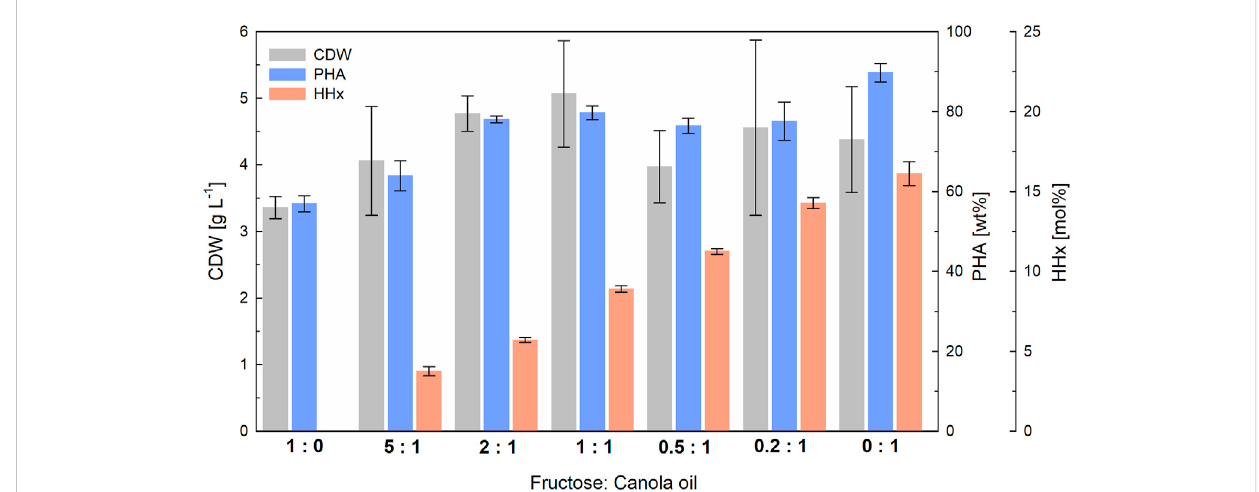
FIGURE 2 Impactofdifferentfructoseto canola oilmixture ratiosonthecompositionofP(HB- co -HHx) in3-mL deep-well-plate cultivations with R. eutropha Re2058/pCB113usingureaasnitrogensource.Celldryweight(CDW;gL − 1 ),PHAcontentofCDW(wt%)andHHxcontentofPHA(mol%)achievedafter72 h with different mixtures with a fi nal carbon content of 5 g L − 1 and a C/N ratio of 22 g g − 1 are displayed. The carbon ratio (g g − 1 ) of fructose to canola oil is indicated for each mixture. CDW error bars indicate standard deviation from biological triplicates. PHA and HHx error bars represent standard deviation from duplicate measurements of pulled